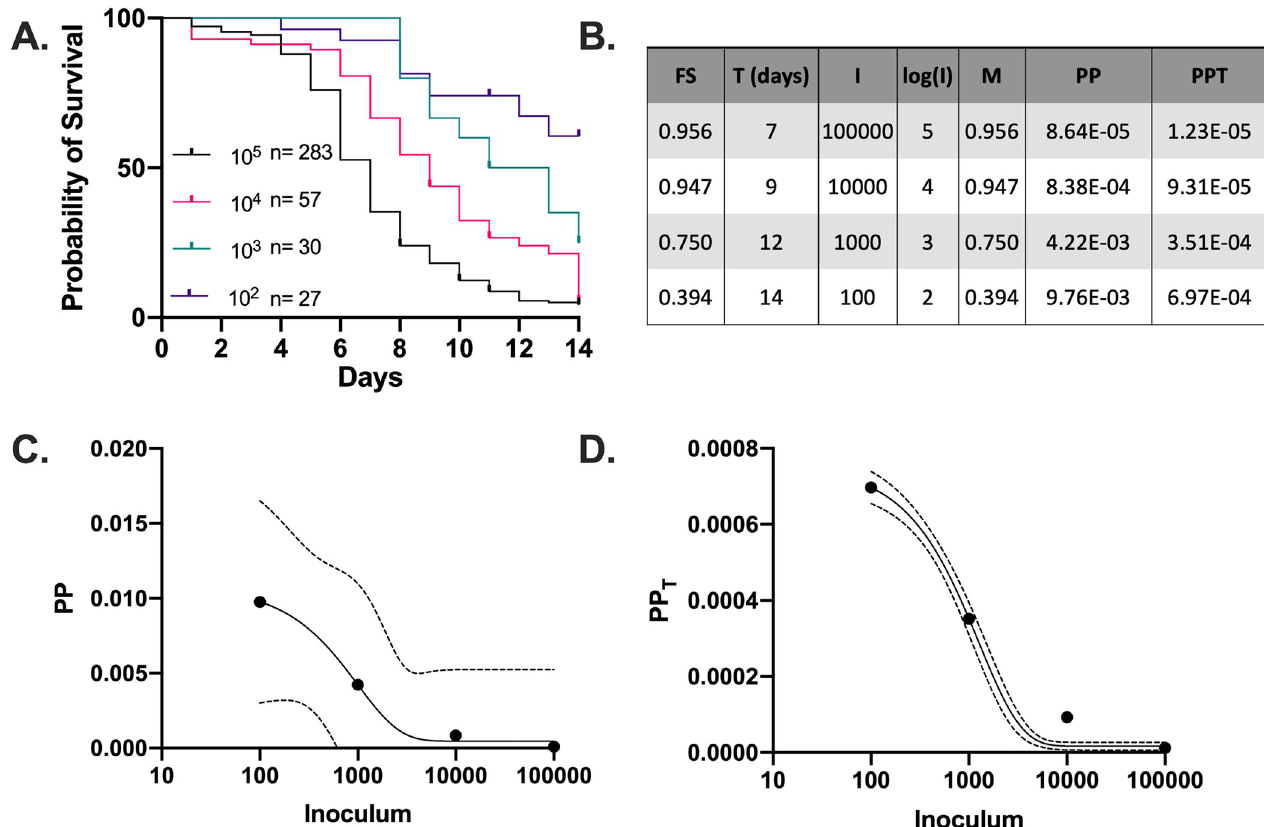
Fig 2. Pathogenic Potential of C. neoformans as a function of inoculum . (A) Survival curves of G . mellonella infected with different inocula of C . neoformans , and the calculated Fs, T, M, and pathogenic potentials (PP and PP T ) (B). Plots of PP (C) and PP T (D) versus I on log-scaled x-axes. These show a negative exponential relationship between pathogenic potential and inoculum, as fitted by a one phase exponential decay function. 95% CI of the exponential fit line is shown with dotted lines.